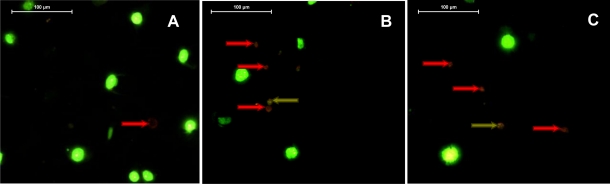
Violaxanthin induces apoptosis of MCF-7 cells. Cells were incubated for 48 h in the presence of 0, 8 or 20 μg·mL−1 of violaxanthin (A, B and C, respectively). Fluorochromes: BOBO-1 (green) and Annexin-V-Alexa 568 (red).